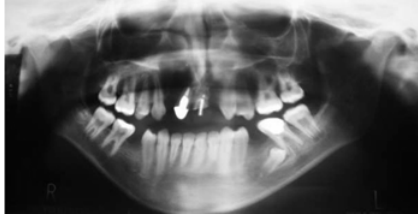
FIGURE 4- Mandibular left 2nd premolar presenting crown impaction against the mesial root of the mandibular left 1st molar at the age of 12